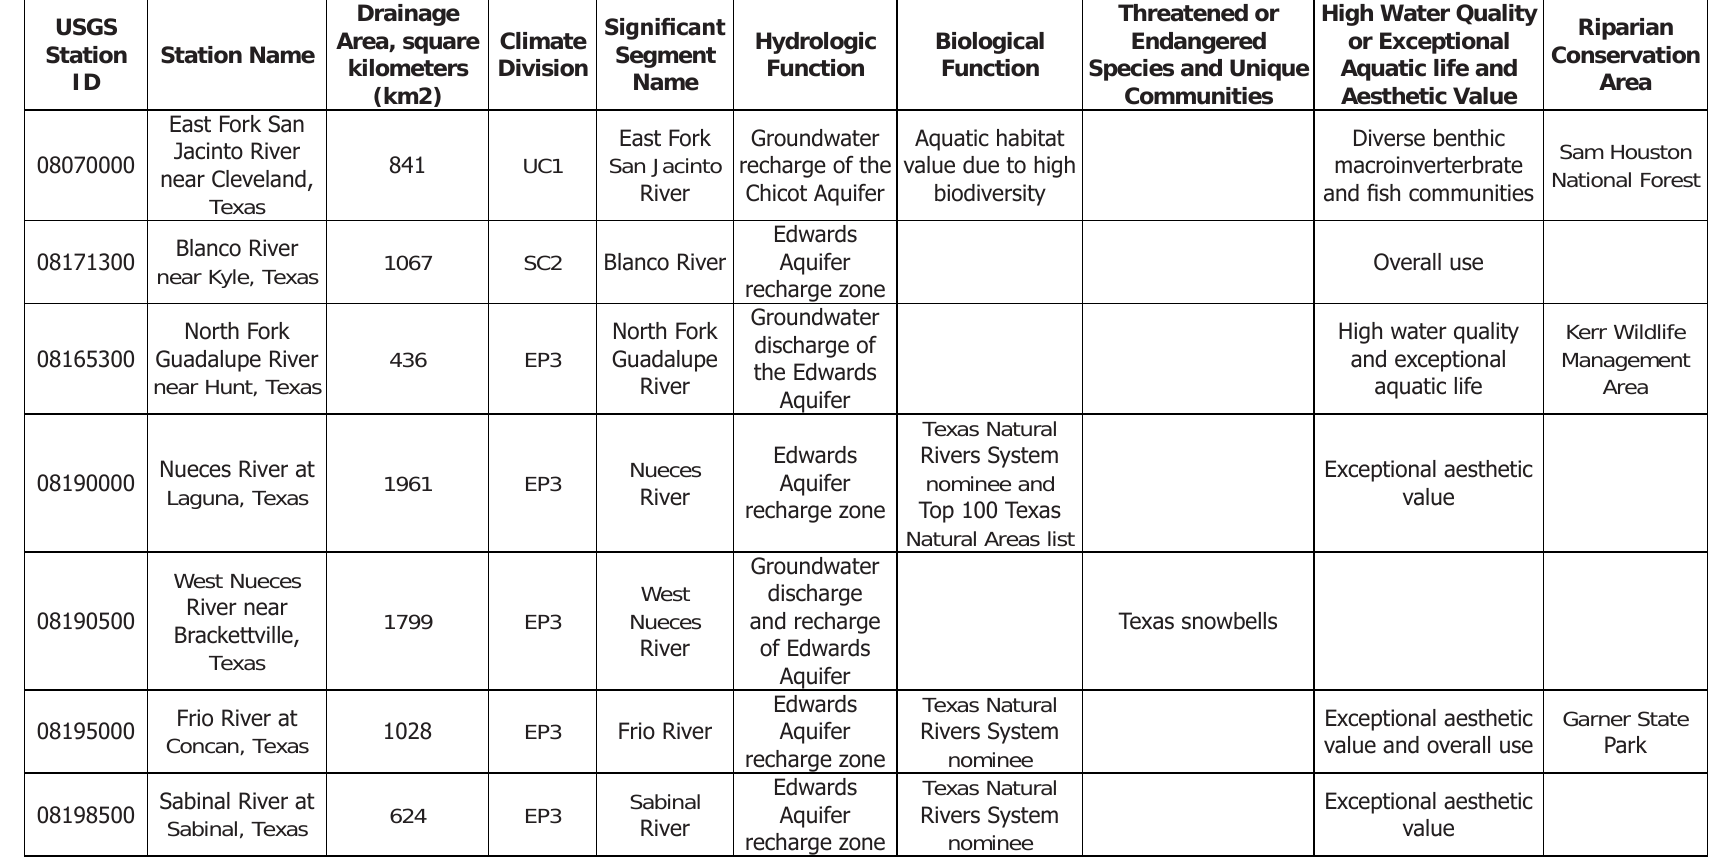
Table 1. Descriptions of the hydrologic function and other functions served by the stream segments monitored by the USGS HCDN gages utilized in this study.